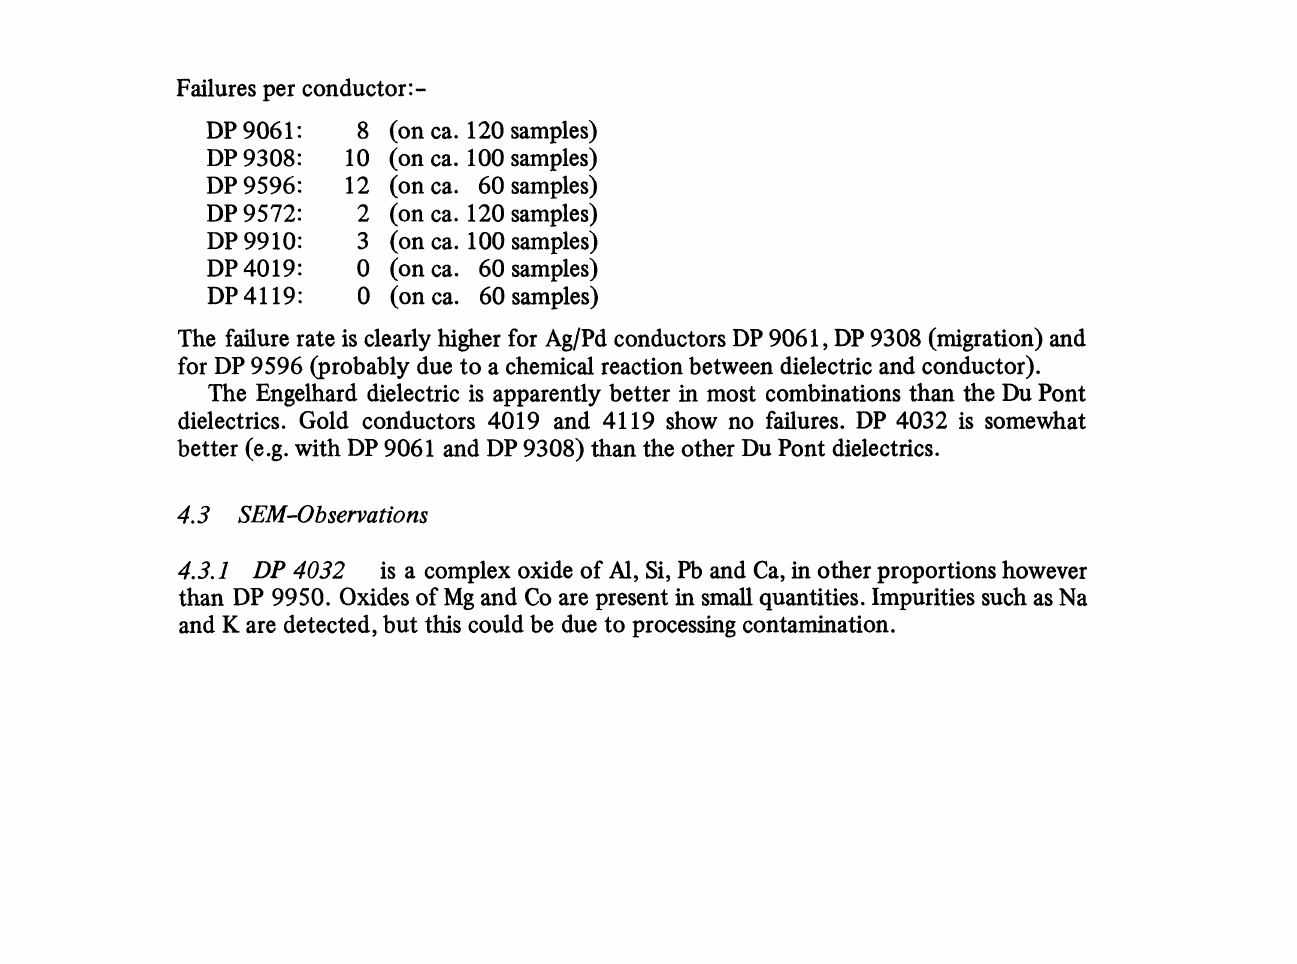
FIGURE 7 Breakdown voltage of various materials, no glaze, no encapsulation, glaze DP 9137, no encapsulation, ++++++ glaze De 9137, encapsulation Durez